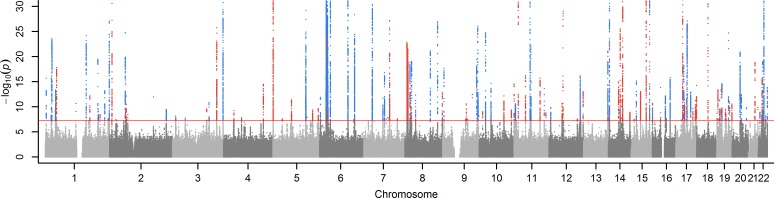
Genetic variants associated with RDW in GWAS of 116,666 UK Biobank participants.The variants are grouped into 194 independent signals, colored blue if a variant in the signal is associated with any trait in the NHGRI-EBI GWAS catalog of known associations, otherwise colored in red. The y-axis (–log10
p-values) is limited to 30 for clarity, as the max value is 200. See S1 Table for RDW associations for each signal, and S4 Table for mapping to the catalog. Horizontal line p = 5x10-8.